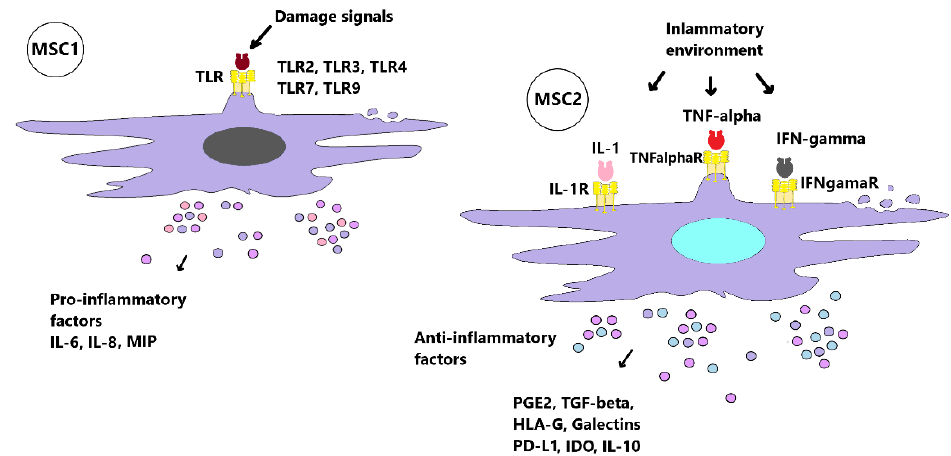
Figure 2. Pro-inflammatory mesenchymal stem cells 1 (MSC1) and the anti-inflammatory phenotype of MSC2. The schemes follow the same formatting that MSCs are able to switch on modulation of the immune system. MSC1s express Toll-like receptors (TLRs), specifically TLR2 and TLR4. The MSC1 phenotype is mostly associated with the early phase of inflammation, being activated by TLR2 or TLR4 receptors. Meanwhile, TLR4 activation induces a pro-inflammatory phenotype, MSC1; pro-inflammatory MSC1 releases interleukin 6 (IL-6) and IL-8, and promotes macrophage polarization to the M1 phenotype. MSC1 is further able to enhance T cell responses by secreting chemokines, i.e., macrophage inflammatory proteins (MIPs). In the presence of an anti-inflammatory environment with high levels of tumor necrosis factor alpha (TNF- α ) and interferon gamma (IFN- γ ), MSCs are activated and adopt an anti-inflammatory phenotype. The anti-inflammatory phenotype of MSC2 is characterized by high levels of the immunosuppressive factors indamine 2,3-dioxygenase (IDO), HLA-G, transforming growth factor beta (TGF-beta), galectins, and